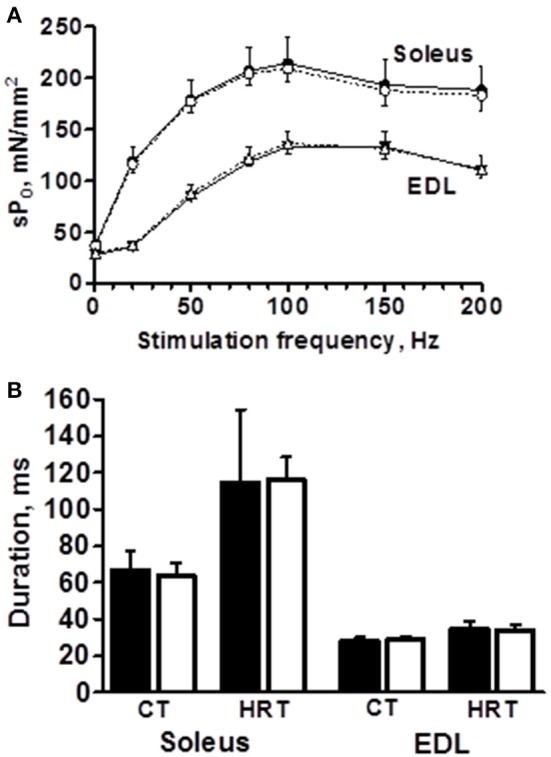
Contractile properties of isolated slow- (soleus) and fast-twitch (extensor digitorum longus, EDL) muscles are not associated with chromosome 10 genotype. Force-frequency relationship expressed as specific force (A), contraction (CT) and half relaxation times (HRT) of single twitch (B) are shown. Black symbols/bars represent B6 and white B6.A10 strain. Mean and SD shown.